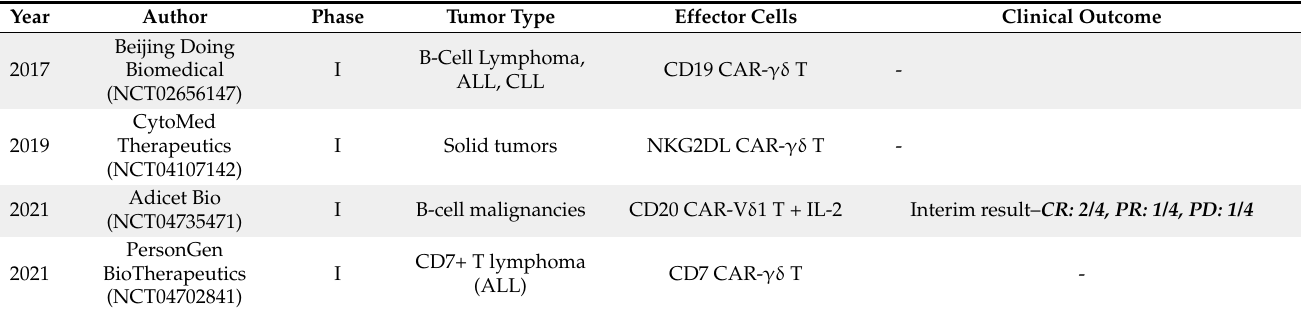
Table 4. Allogeneic, ex vivo expanded CAR- γδ T cell clinical